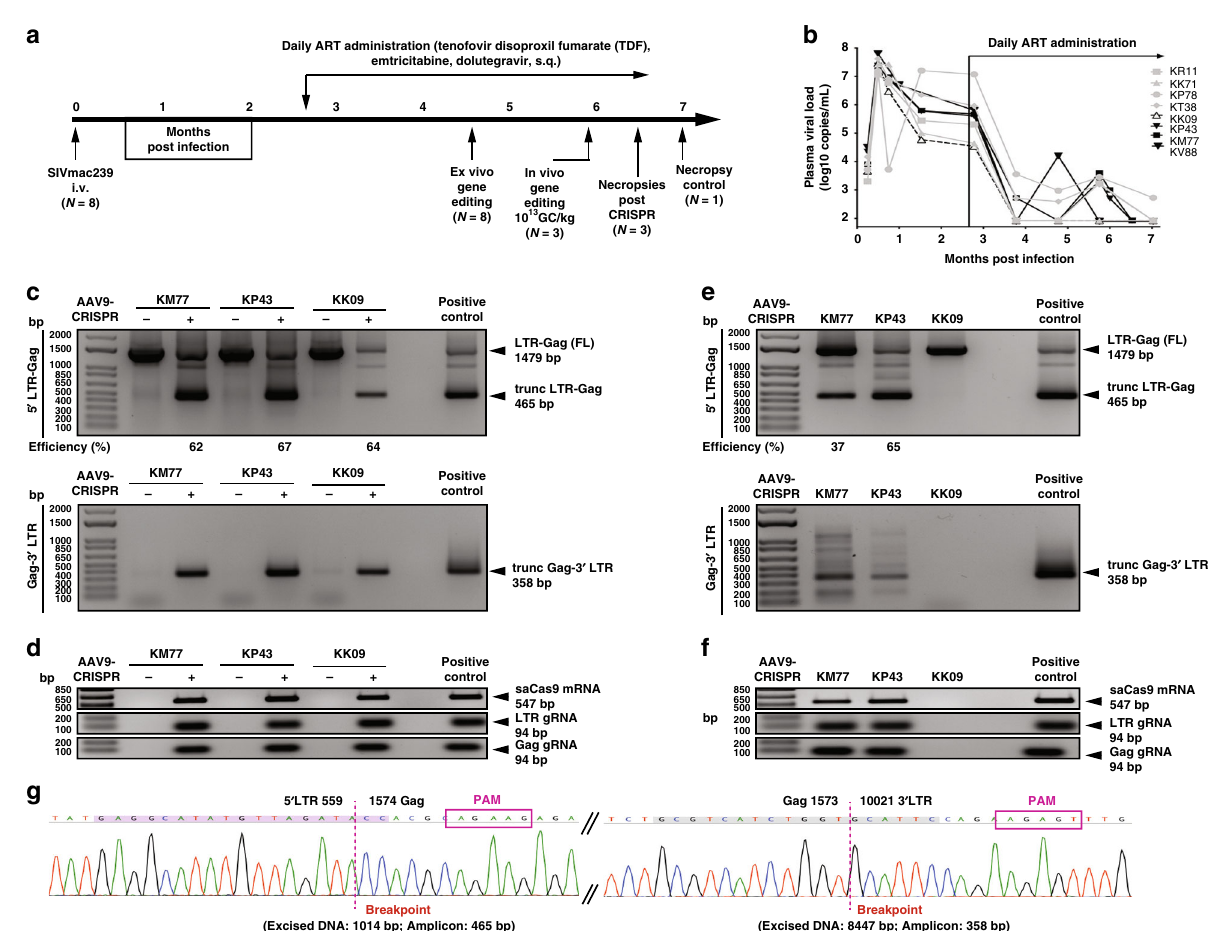
Fig. 2 Excision of SIVmac239 DNA by CRISPR-Cas9 in the blood of SIV-infected rhesus macaque monkeys. a Chinese rhesus macaques were i.v. inoculated with SIVmac239 and given a daily ART administration of tenofovir disoproxil fumarate, emtricitabine and dolutegravir, s.q. starting at 78 days post infection. Three animals (KM77, KP43 and KV88) were given 10 13 GC/kg, i.v. and 3 weeks later underwent necropsy. One animal served as the no CRISPR control (KK09). b Plasma viral loads of the SIV-infected ART-treated rhesus macaques. The threshold of the assay was 83 copies/ml. The animals in solid black symbols and lines received AAV9/CRISPR/Cas9. The open black triangle with a dotted line (KK09) was sacri fi ced as no AAV9/CRISPR control. The gray symbols and lines were animals that were only used in the ex vivo screening. All viral loads were done in duplicate per time point. c AAV9-mediated delivery of CRISPR/Cas9 to ex vivo PBMCs from SIVmac239-infected animals was able to excise SIV viral DNA. Truncated 5 ′ LTR-gag (465 bp) and gag-3 ′ LTR (358 bp) amplicons were detected in lanes with AAV-9 CRISPR/Cas9 ( + ) but not in the untransformed ( − ). The percent excision ef fi ciency ex vivo (Ef fi ciency (%)) shown under the PCR was calculated by quanti fi cation of the excised band (Trunc.) divided by the sum of the full-length band (FL) plus the excised bands times 100% (see Supplementary Fig. S1 for all animals). d Expression was veri fi ed by the presence of SaCas9 mRNA (547 bp), LTR and Gag gRNA scaffolds (94 bp). e Similarly, in vivo excision was con fi rmed in the blood of KM77 and KP43 by the PCR ampli fi cation and detection of the trunc 5 ′ LTR to gag (465 bp) and the gag-3 ′ LTR (358 bp) (see Supplementary Fig. S3 for KV88). The percent excision ef fi ciency (Ef fi ciency (%)) in vivo shown under the PCR was calculated as above. KK09 did not receive CRISPR so no ef fi ciency was calculated. f Expression was veri fi ed by the presence of SaCas9 mRNA (547 bp), LTR and Gag gRNA scaffolds (94 bp). g Representative Sanger sequence tracings of 5 ′ LTR-Gag (left) and Gag-3 ′ LTR (right) CRISPR-Cas9 induced truncated SIV-speci fi c amplicons. Target sites are highlighted in green, PAMs motifs in red, the double cleaved/end-joined site is shown as a breaking point in red. Full sequencing data are available in the source fi le data provided with this paper. Source data are provided as a Source Data fi